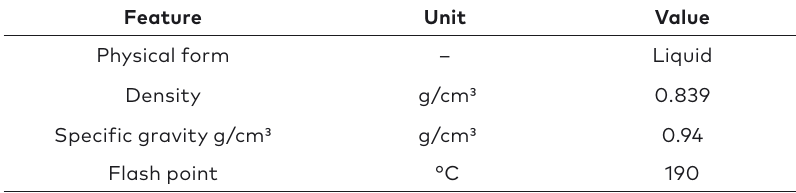
Table 6. Physical properties of rejuvenator Evoflex CA ©